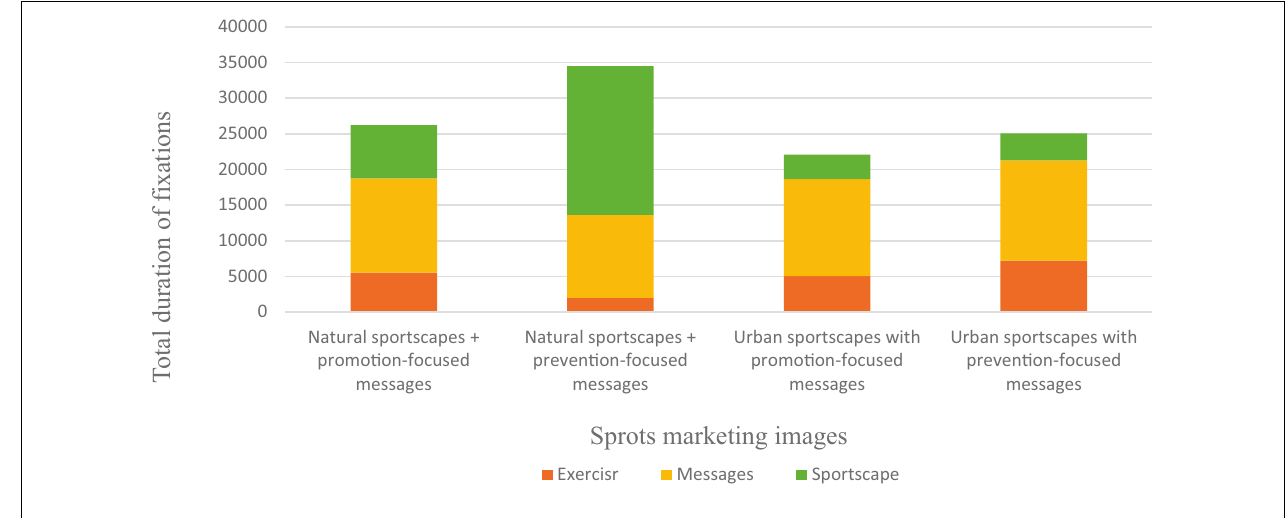
FIGURE 3 | Total average duration of fixation on the different AOIs among the four types of sports marketing